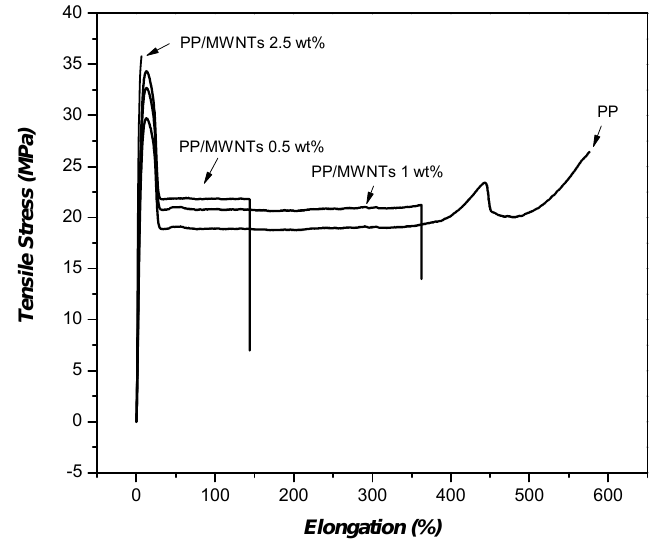
Stress–strain curves of PP/MWCNTs nanocomposites containing different MWNT